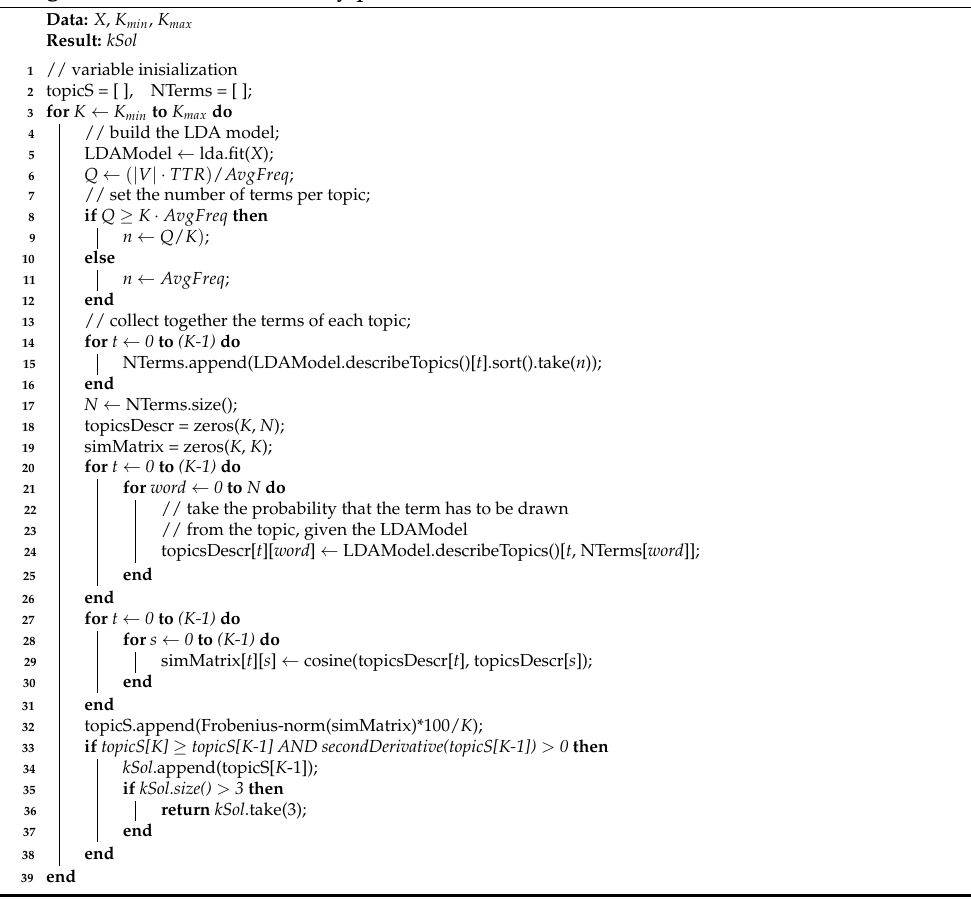
Algorithm 2: ToPIC-similarity